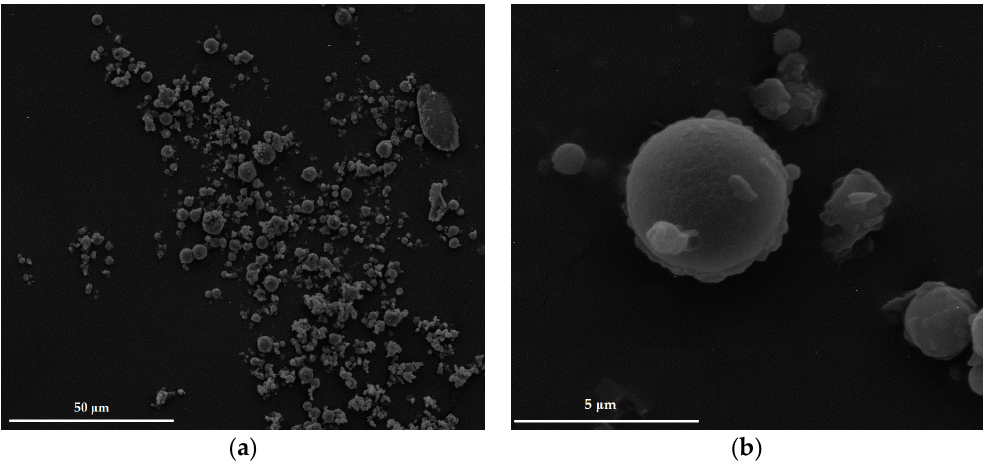
Figure 1. Representative images of microparticles formulation CH1M under magnification: ( a ) ×2000; and ( b ) ×20,000. Table 1. Characteristics of non cross-linked microparticles formulation C and cross-linked microparticles formulation CH1M and CH2M.